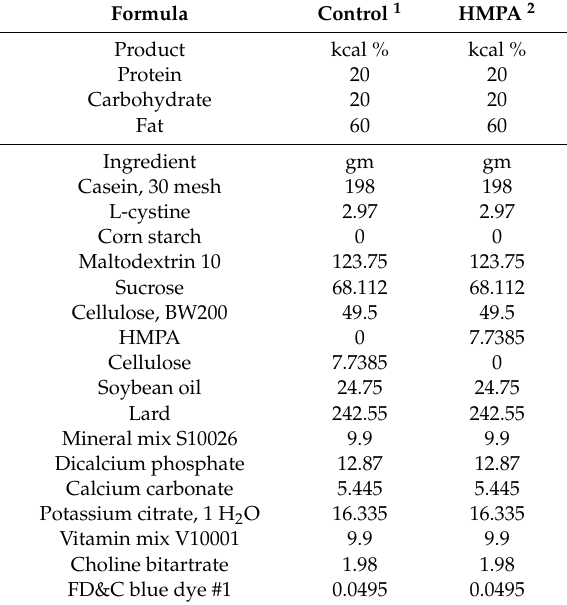
Table 2. Diet compositions.